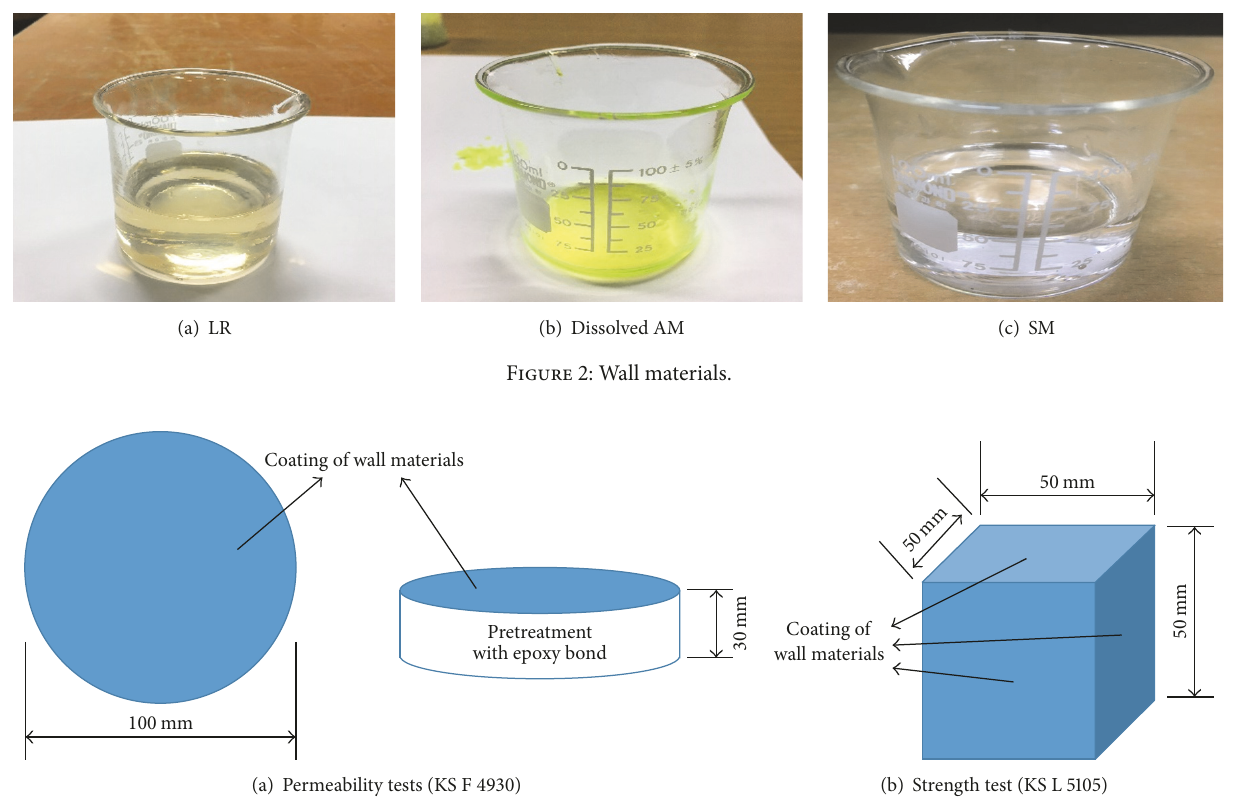
Figure 3: Evaluation methods for wall